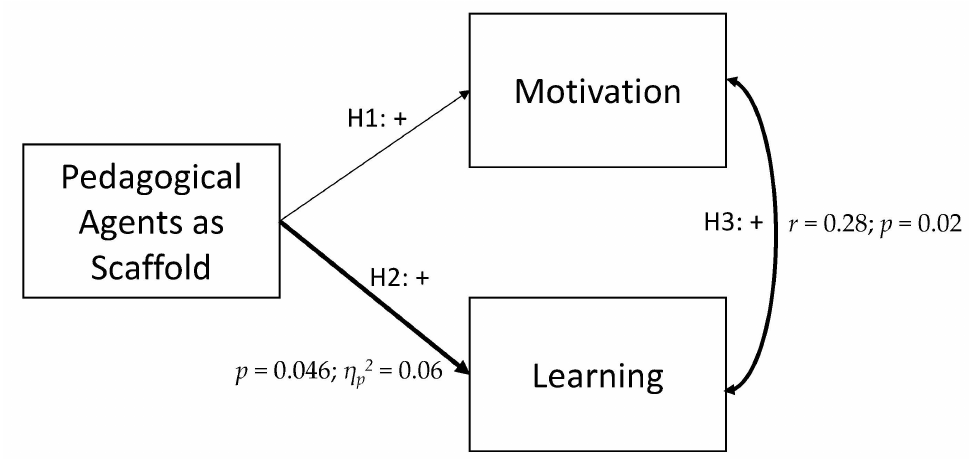
Figure 4. Core findings of this